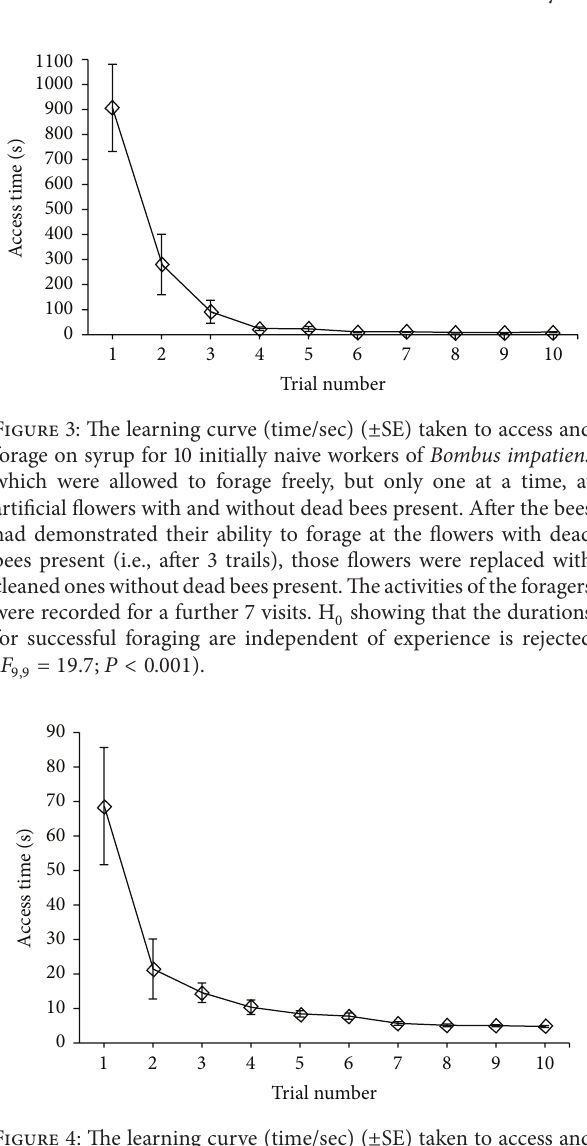
Figure 4: The learning curve (time/sec) ( ± SE) taken to access and forage on syrup for 9 workers of Bombus impatiens which were allowed to watch experienced foragers at artificial flowers for 10 hours and held incommunicado overnight. In the morning these bees demonstrated their ability to forage at the flowers after 3 trails. The flowers were replaced with cleaned ones after each of the first three trials and for each individual bee tested. The activities of the foragers were recorded for a further 7 visits. H 0 showing that the durations for successful foraging are independent of experience of having watched nestmates forage is rejected ( 𝐹 8,9 = 10.7 ; 𝑃 < 0.001